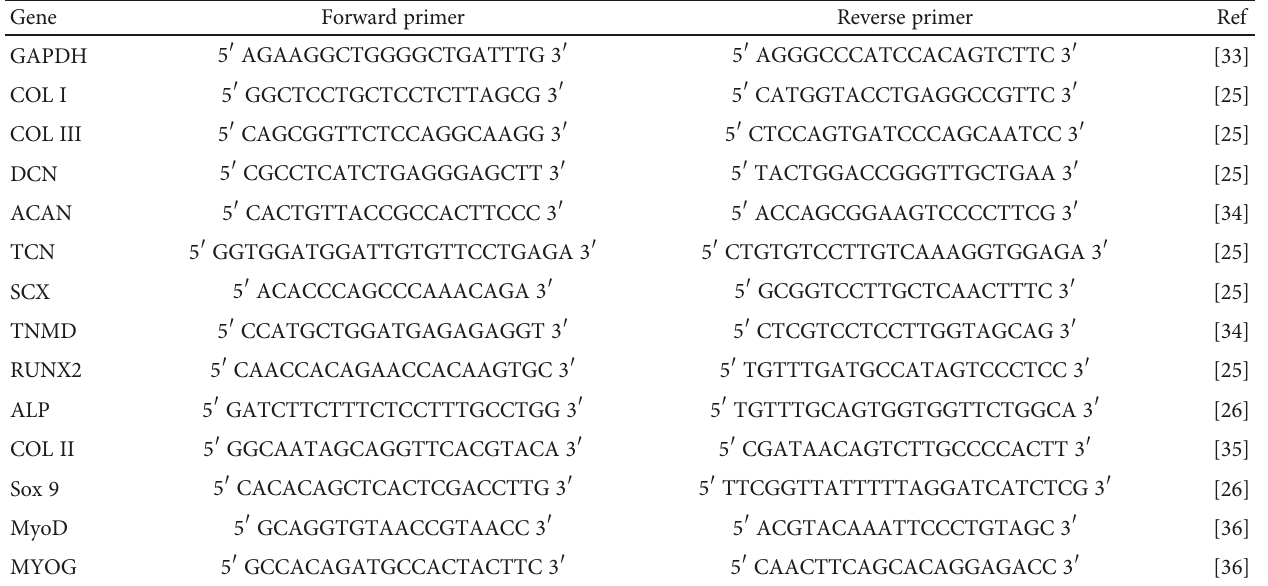
Table 1: Forward and reverse primers used for real-time